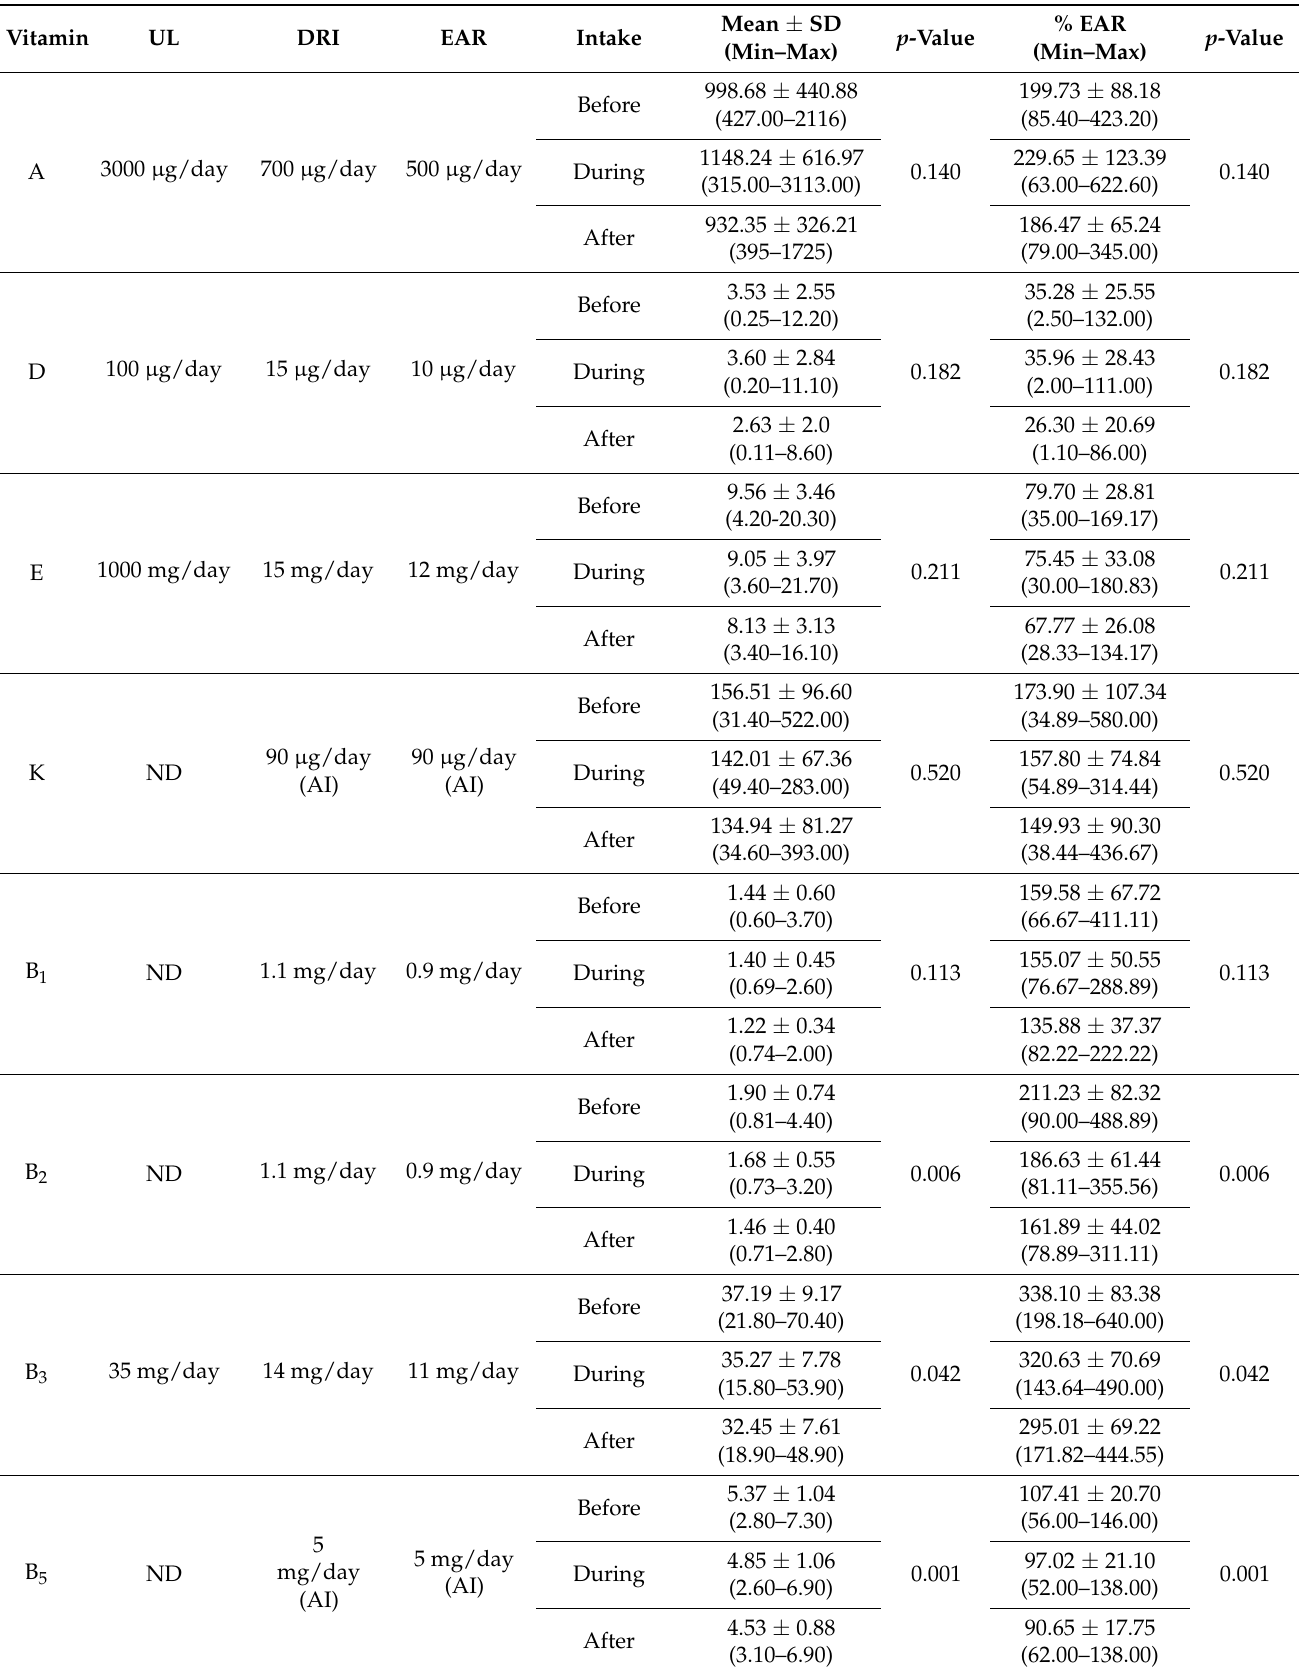
Table 2. Vitamin intake in the three stages of the